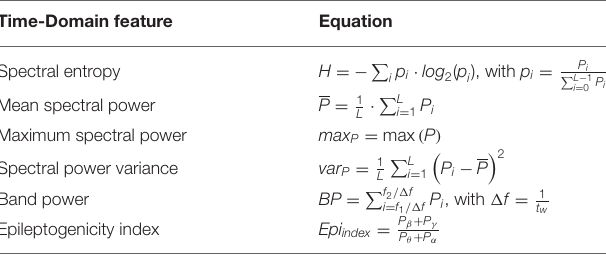
TABLE 5 | Frequency-domain features and their respective equations that were considered in this work. Time-Domain